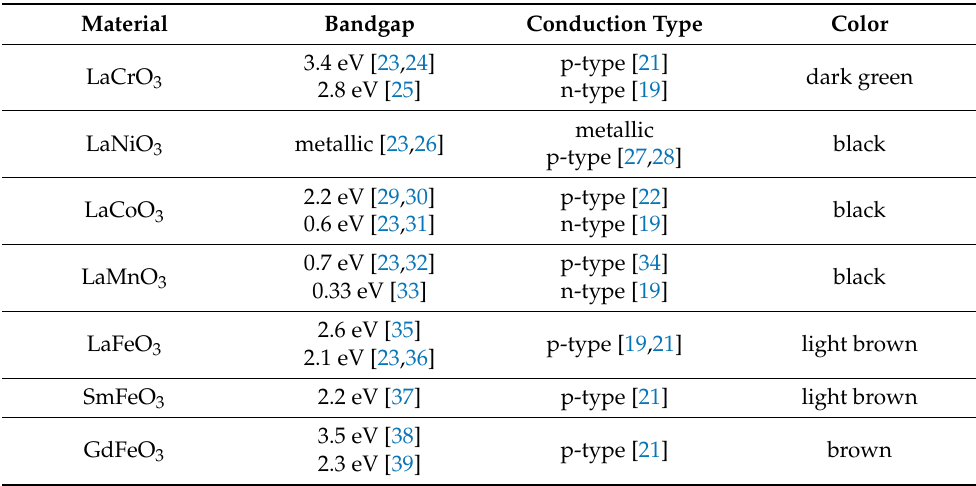
Table 1. Properties of different perovskite